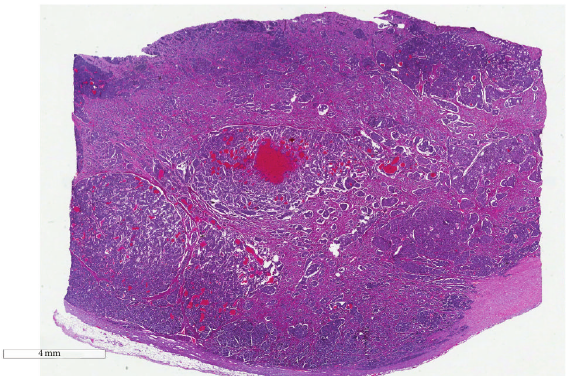
Figure 2: Histological examination (hematoxylin-eosin staining; magnification 4x) of the resected small bowel specimen showing a neuroendocrine carcinoma composed of islands of uniform cells embedded within fibrous